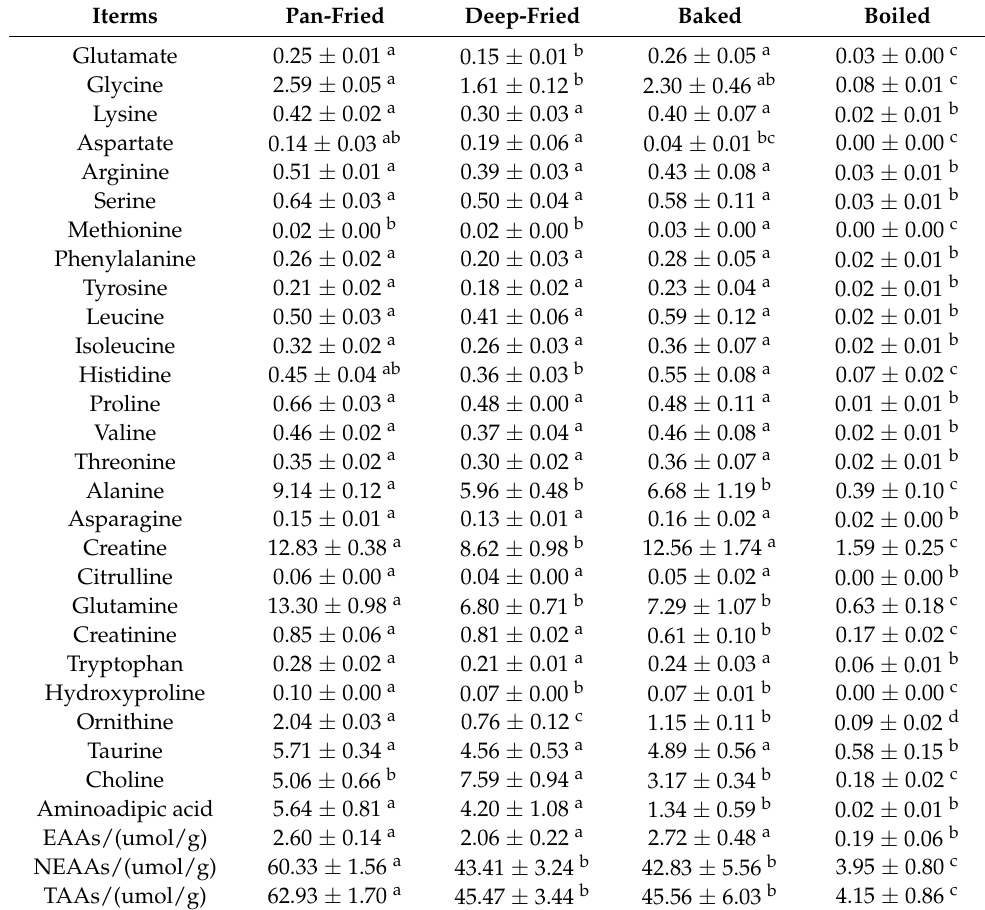
Table 4. Amino acids of BTS meat under different processing methods